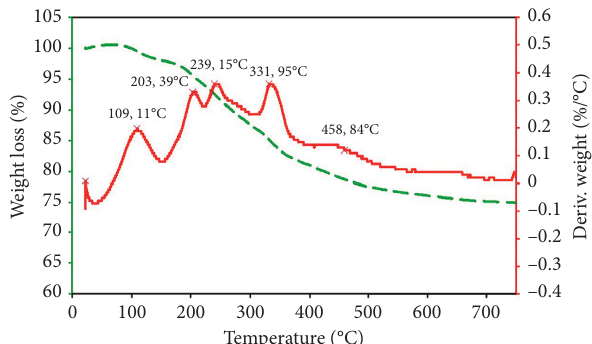
Figure 6: A plot of TG/DTA for the Tunisian pomegranate peel thermal behavior.